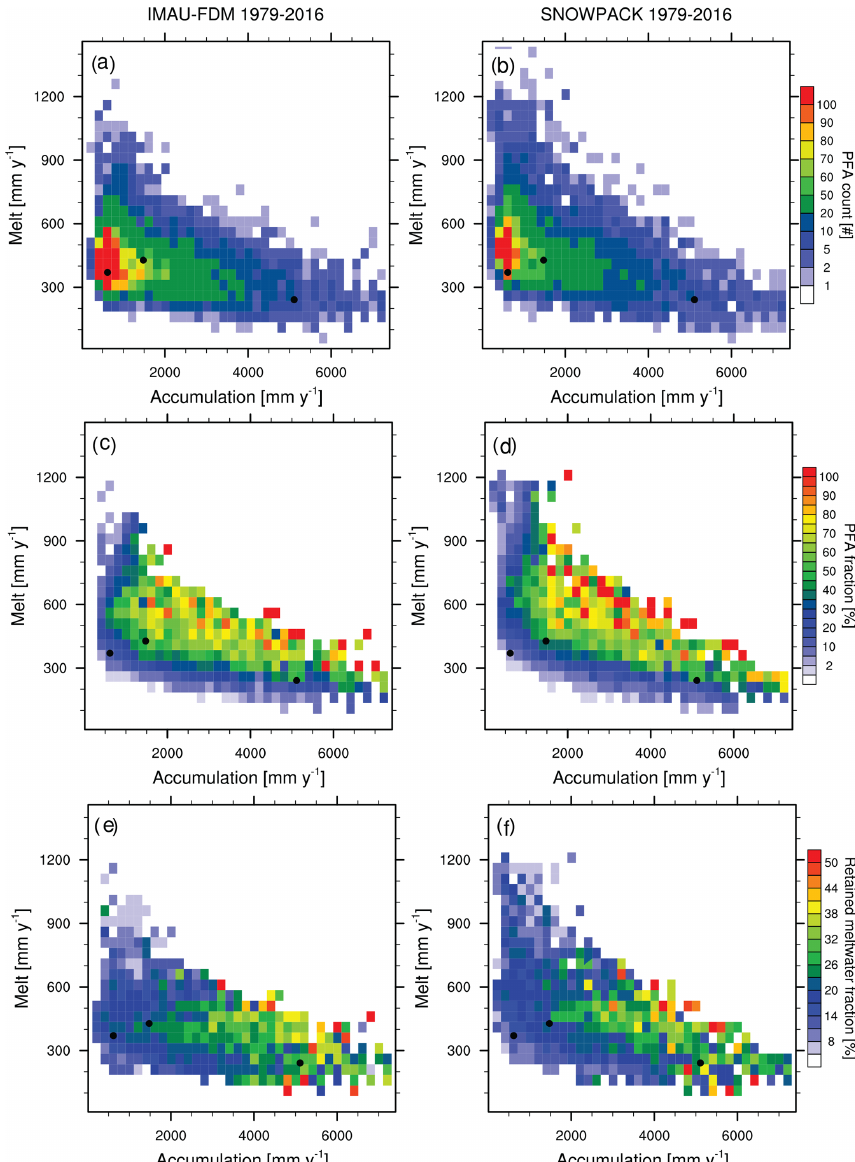
Figure 9. (a, b) Occurrences of (increases in) perennial firn liquid water content (as defined in text) in IMAU-FDM (left column) and SNOWPACK (right column) for all model grid points in the respective hydrological year of the PFA, (c, d) percentage of total number of PFA occurrences (with respect to Fig. 8a, b), and (e, f) percentage of total produced meltwater that is retained in the firn at the end of the subsequent winter as a function of yearly surface meltwater production ( y axis) and accumulation ( x axis). PFA numbers are binned in 50mmw . e . yr − 1 intervals in the y direction and by 200mmw . e . yr − 1 in the x direction. Grid points with only one occurrence are not